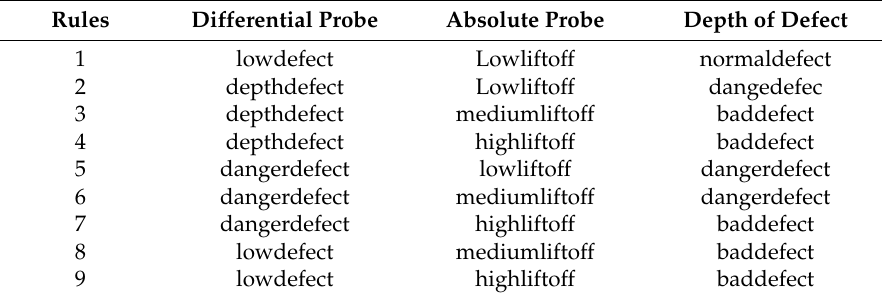
Table 2. Mamdani-Type Fuzzy Interface System (FIS)